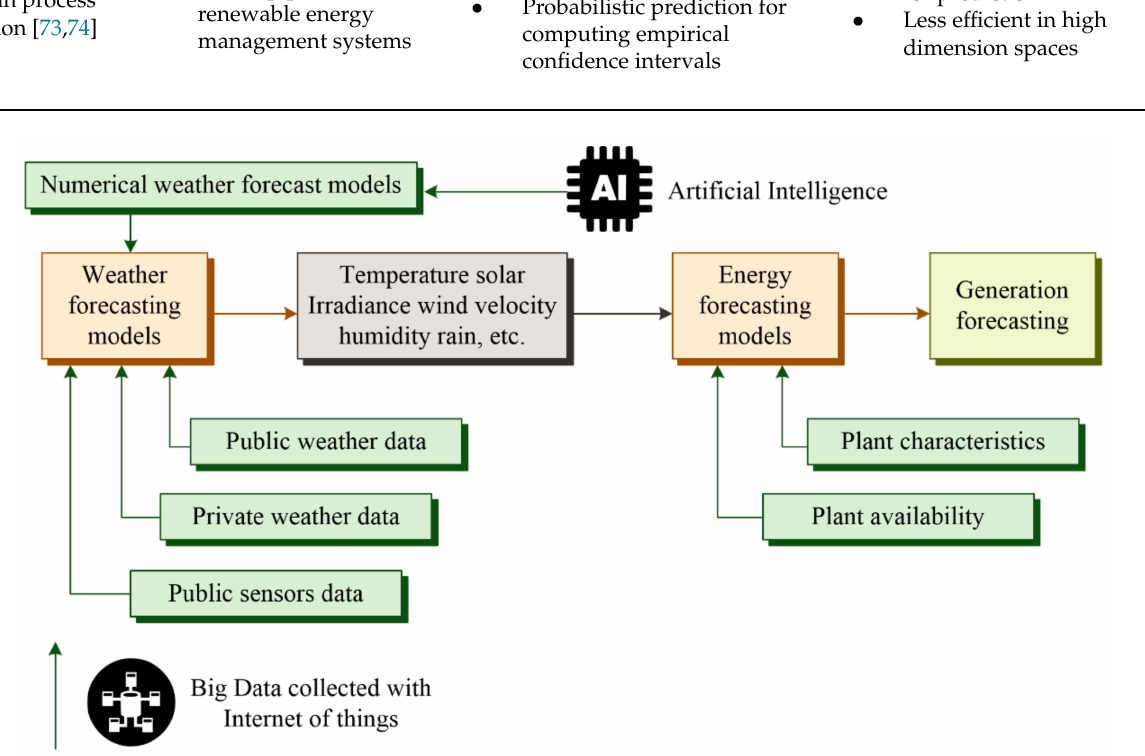
Figure 8. Requirements for solar power forecasting with AI